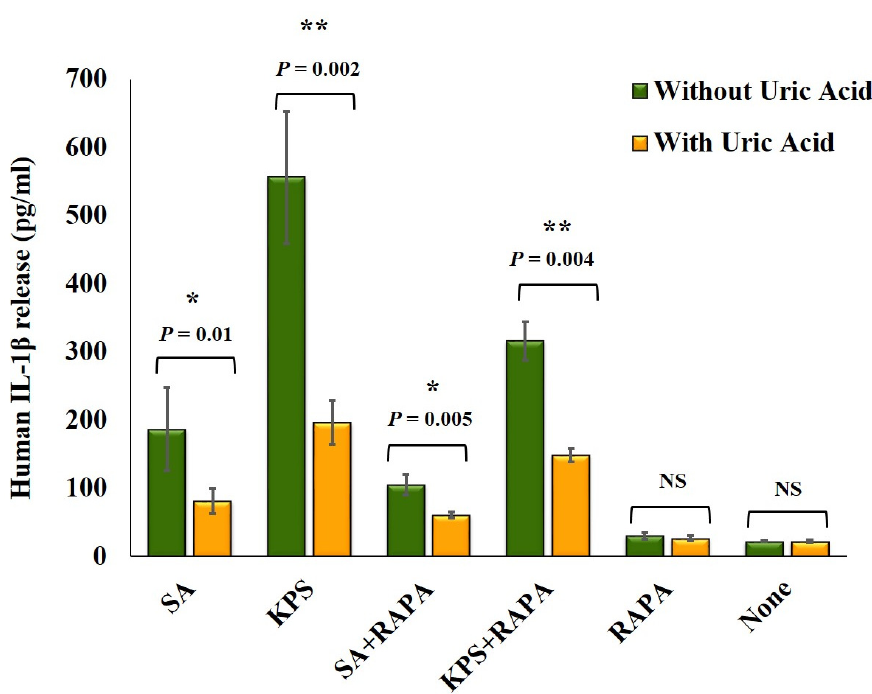
Figure 4. Soluble uric acid attenuates IL-1 β released from macrophages infected with live bacteria. IL-1 β release from human THP-1 monocytic cells infected with live bacteria at a multiplicity of infection (MOI) of 10 in presence and absence of soluble uric acid (19 mg / dL) and Rapamycin for three hours prior to the addition of Gentamycin, Penicillin, and Streptomycin, then incubated overnight. IL-1 β released in the supernatants was quantitated using ELISA method. These data represent the mean of two independent experiments with bars showing the standard error of the mean. SA: S. aureus ; KPS: K. pneumoniae sensitive to antibiotics; RAPA: Rapamycin; UA: uric acid; ns: not significant. p value < 0.05 are significant, * in comparison to SA without Rapamycin, ** in comparison to KPS without Rapamycin.